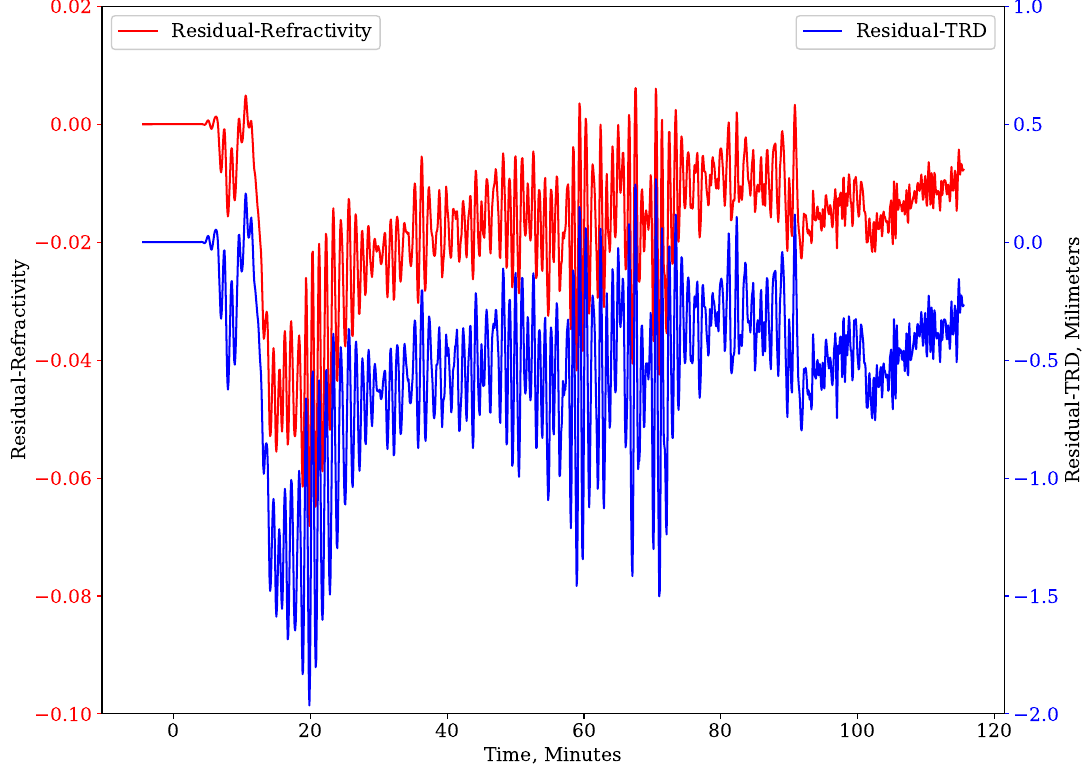
Figure 9. It demonstrates the time vs. Residual-Refractivity and time vs. Residual-TRD over the